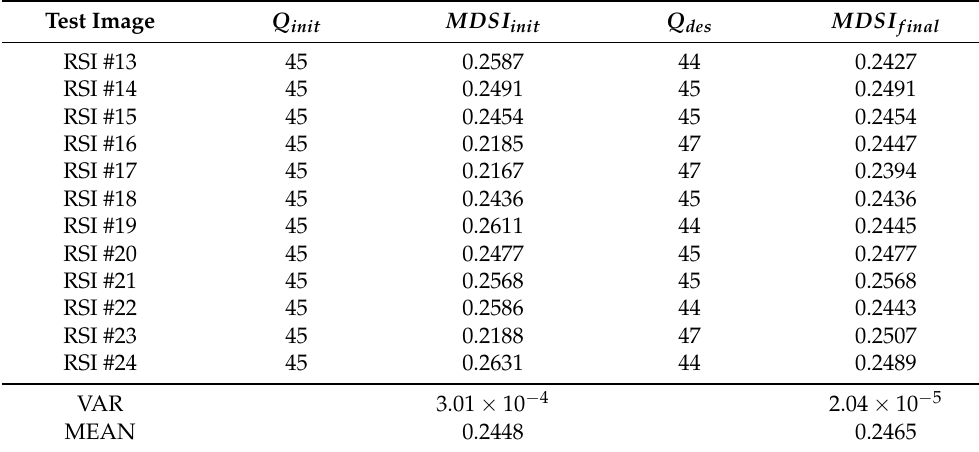
Table 5. The experimental data obtained for the test image set assuming the desired value of MDSI =